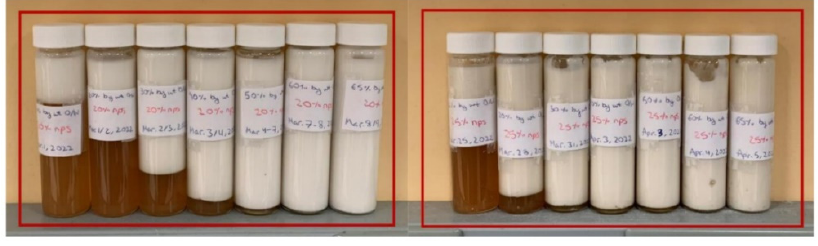
Figure 18. Creaming in O/W emulsions when left unstirred for several weeks.